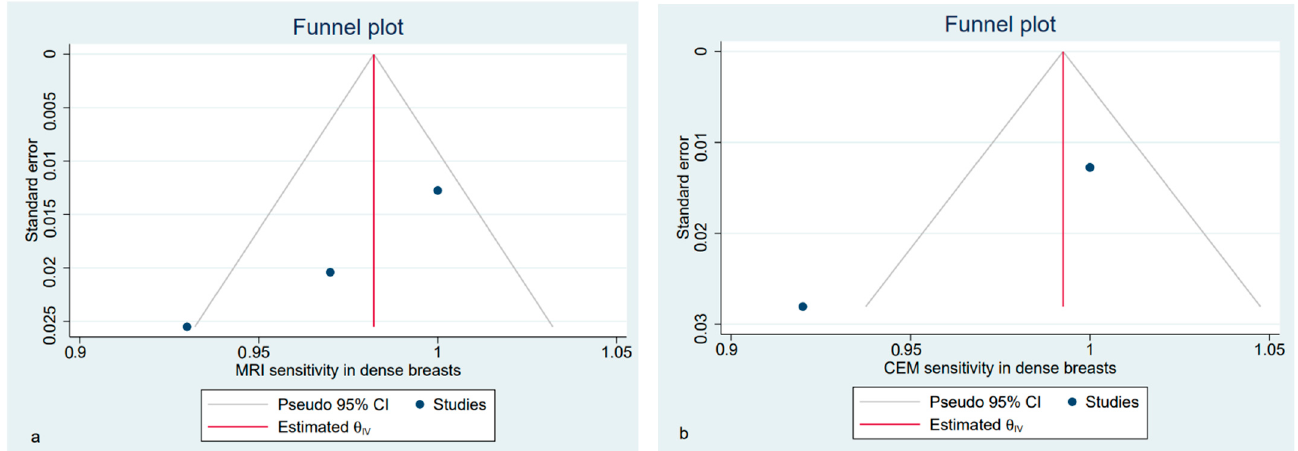
Figure 11. Funnel plot with 95% CIs for publication bias assessment of pooled sensitivity for CE- MRI ( a ) and CEM ( b ) for the detection of pathological breast lesions in women with dense breasts. Table 1 summarizes the results (i.e., sensibility, specificity, heterogeneity, and significance) of all of the analyses performed.